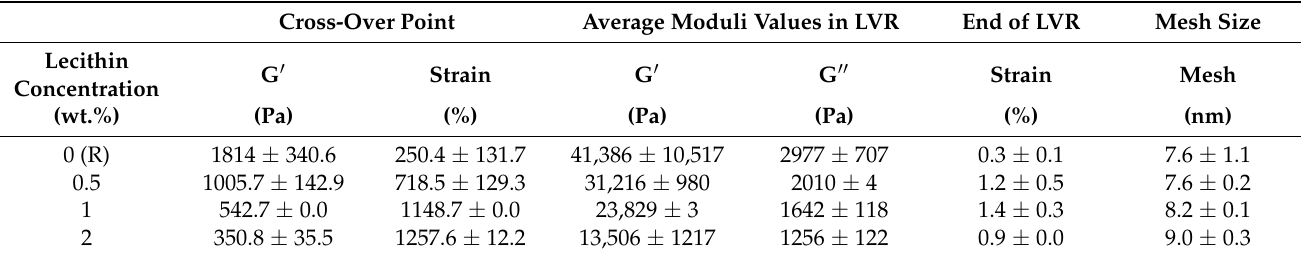
Table 2. Values obtained from strain and frequency sweep tests for physically crosslinked agarose hydrogels after drying and